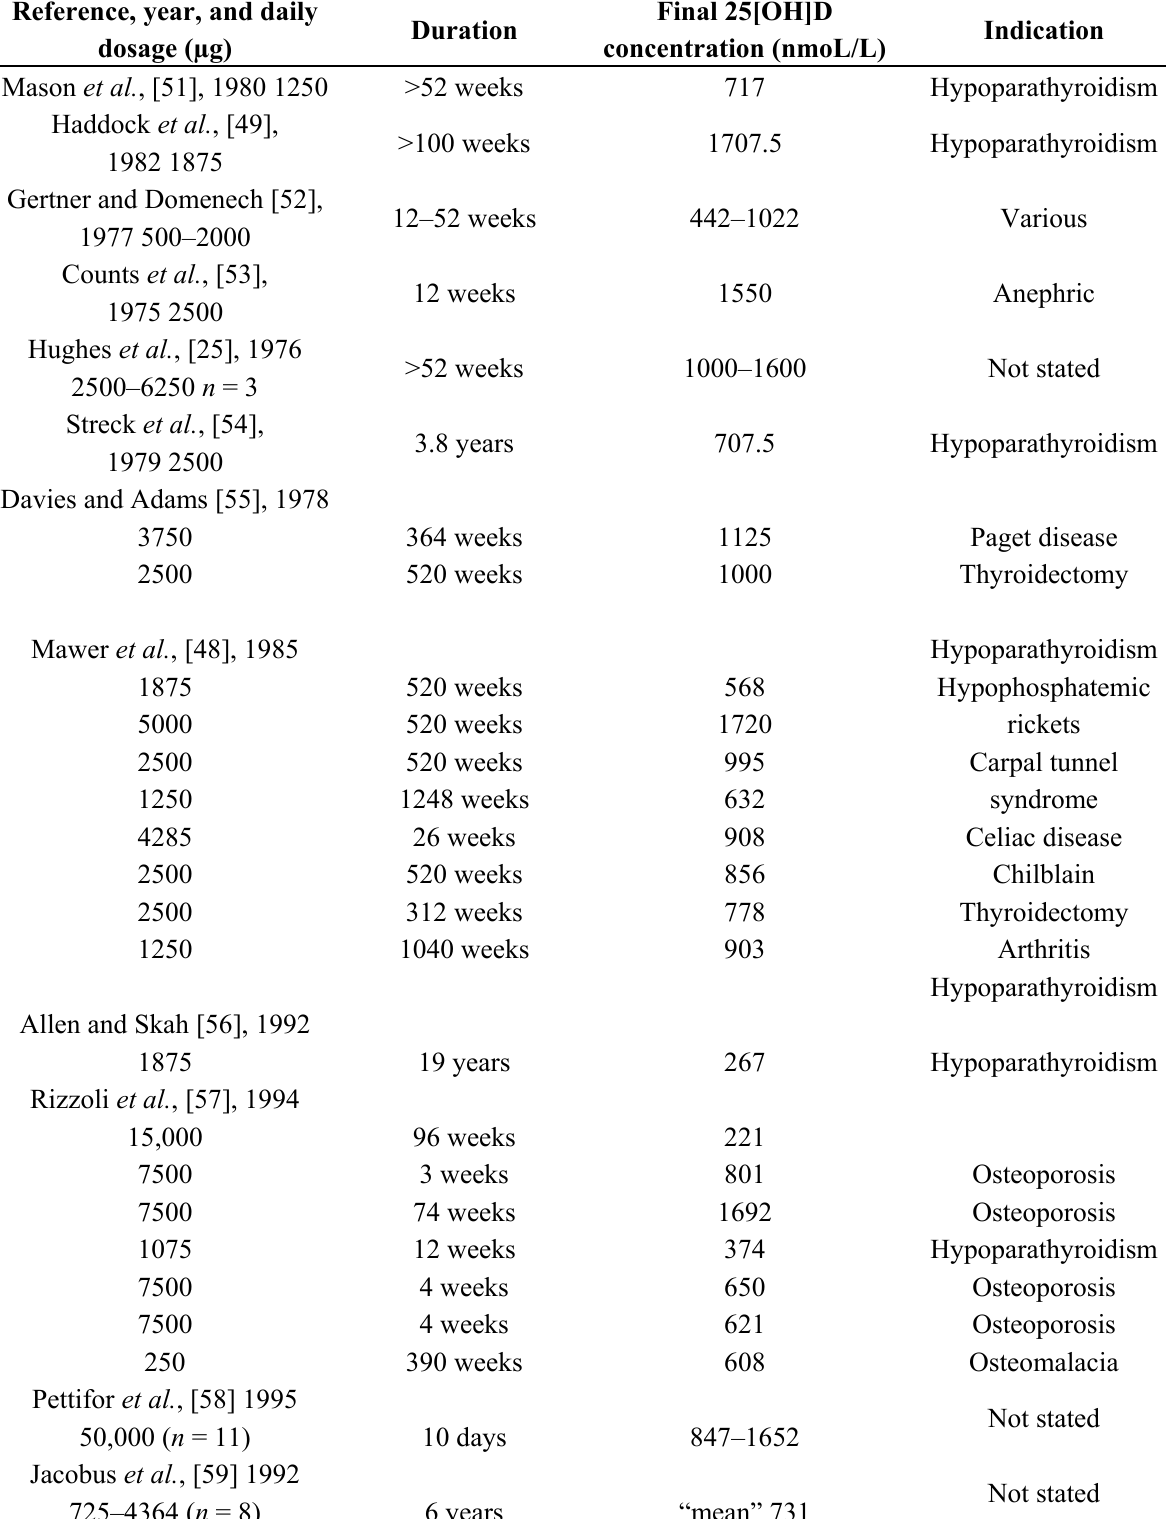
Table 6. Studies reporting elevated vitamin D status and associated